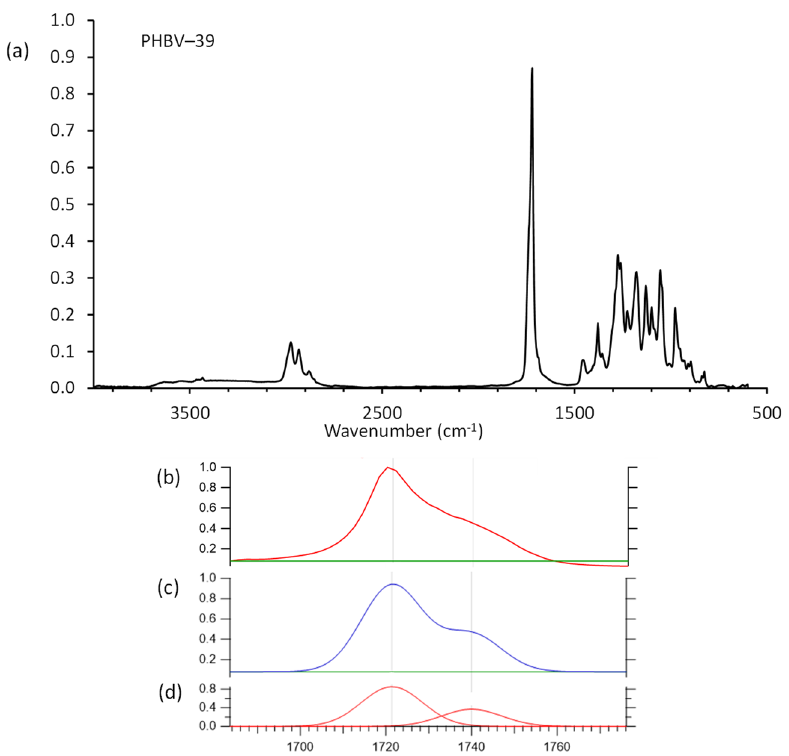
Figure 1. ( a ) FTIR spectrum for purified PHBV-39 sample; ( b ) expanded spectrum showing the carbonyl region before fitting; ( c ) expanded spectrum showing the carbonyl region after fitting; ( d ) fitted carbonyl bands.